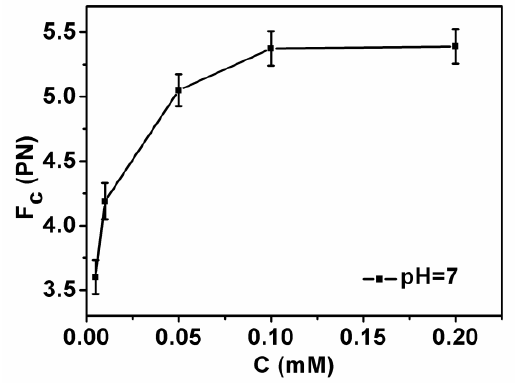
Figure 7. DNA condensing force as a function of chitosan concentration with a fixed pH = 7.